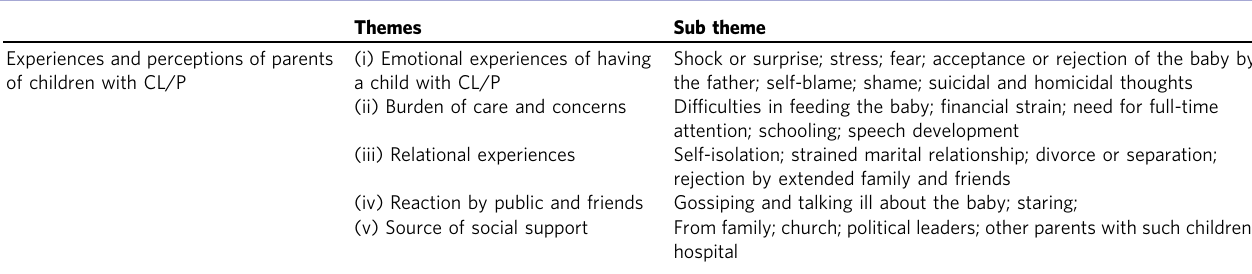
Table 2 Themes on lived experiences and perceptions of parents of children with